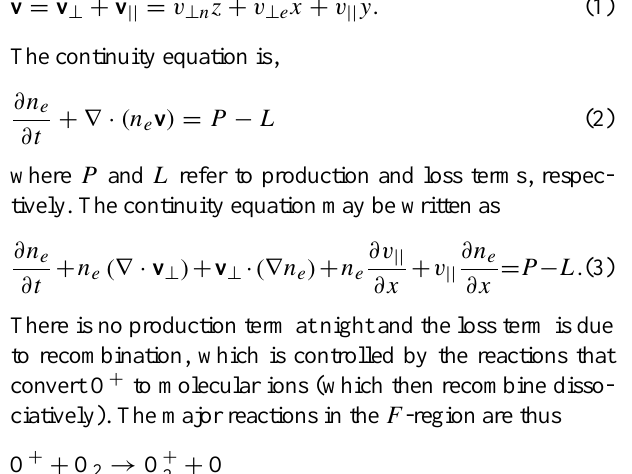
Fig. 5. Monthly averages of fo F2 (top) and h 0 F (bottom) as mea- sured by the Jicamarca digisonde. The black curves correspond to winter / summer data and the gray curves correspond to equinox